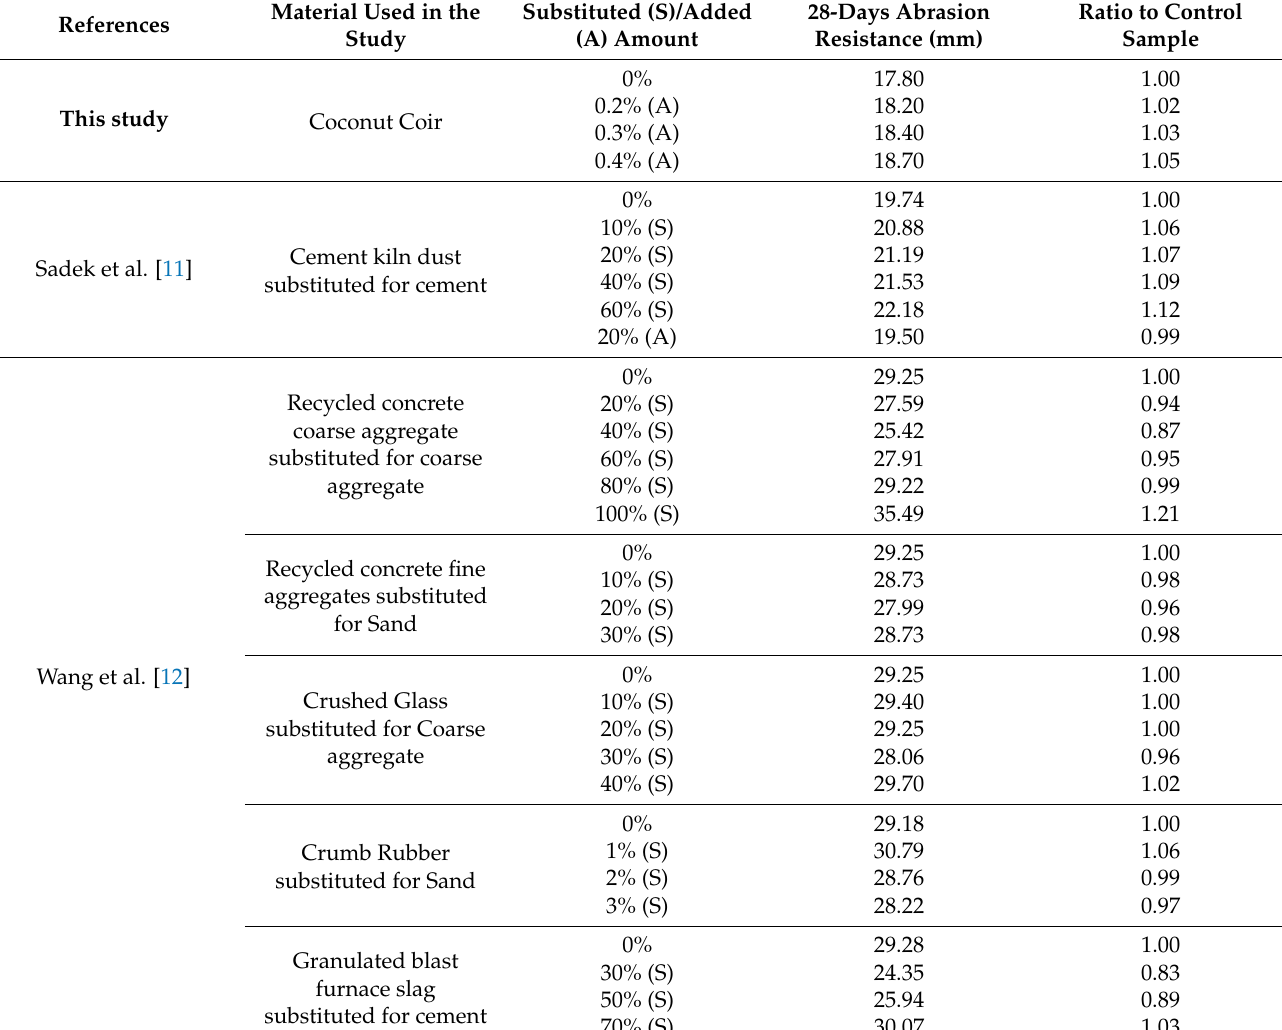
Table 10 gives abrasion resistance results for various additives and substitutes. An increase in abrasion resistance was observed with coconut coir addition and cement kiln dust substitution. However, a decrease was observed up to 40% recycled concrete coarse ag- gregate, 20% recycled concrete fine aggregate, 30% crushed glass, and 30% granulated blast furnace slag. Furthermore, the maximum increase in abrasion resistance was observed with recycled concrete coarse aggregate, which had increased by 21% when it was completely substituted for coarse aggregate. Moreover, the highest decrease in abrasion resistance was observed with granulated blast furnace slag, which is a 17% reduction. Table 10. Comparison of abrasion resistance of IPBs with other materials.